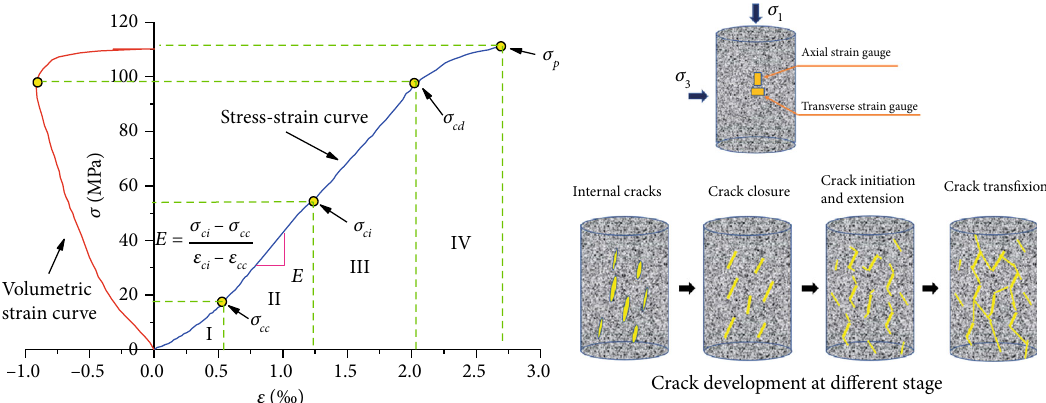
Figure 1: The axial stress-strain and volumetric strain curves of rock progressive